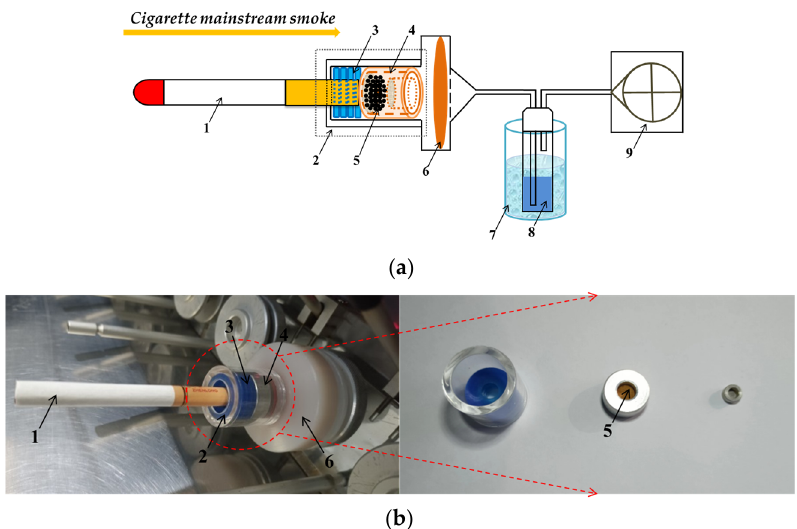
Figure 1. ( a ) Illustration for cigarette smoke adsorption (1: cigarette; 2: homemade device; 3: rubber ring; 4: device for loading adsorbent material; 5: adsorbent material; 6: the particle phase trap with Cambridge filter pad; 7: cold trap containing isopropanol and dry ice; 8: absorption flask with 15 mL of methanol; 9: smoking machine). ( b ) Actual diagram of cigarette smoke adsorption device.